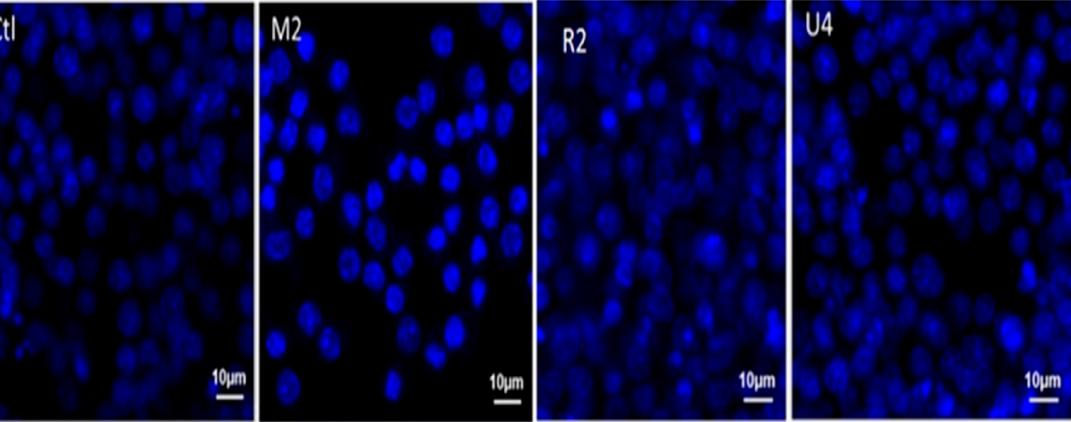
Figure 11. Typical DAPI staining of macrophages in control or particle-exposed conditions in some sites illustrates intense DAPI staining (saturation) due to intense internalization of the dye along with nuclear condensation; note the lower cellular density for the M2 site, corresponding to higher cell death.